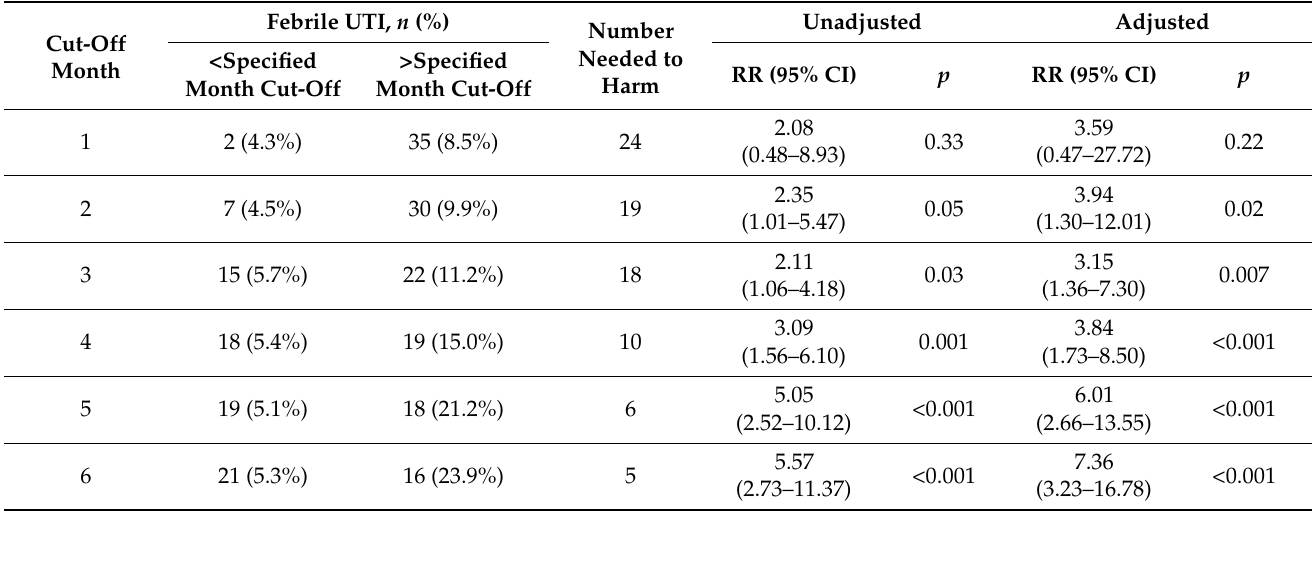
Table 2. Risk of post-ureteroscopic febrile UTI. Adjustments for age, sex, maximum stone diam- eter, operative time, positive pre-operative urine culture and stone free status. RR = Risk ratio, CI = confidence interval. Significance level = 0.0306.